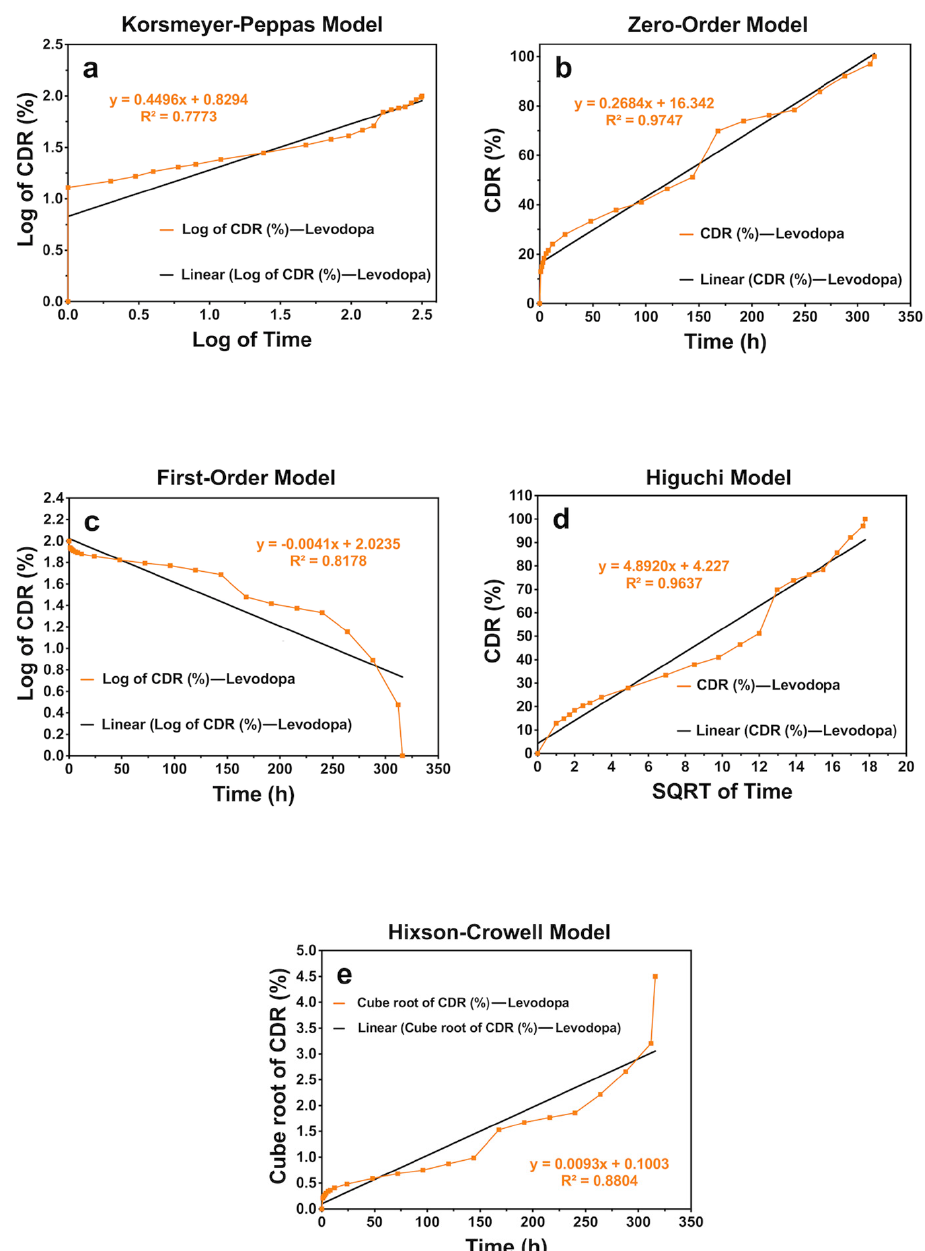
Figure 8. The release kinetic models of levodopa release profiles from the scaffolds that have the concentration of levodopa at 0.05 mg/mL for 336 h: ( a ) Korsmeyer–Peppas, ( b ) zero-order, ( c ) first- order, ( d ) Higuchi, and ( e ) Hixson–Crowell models.